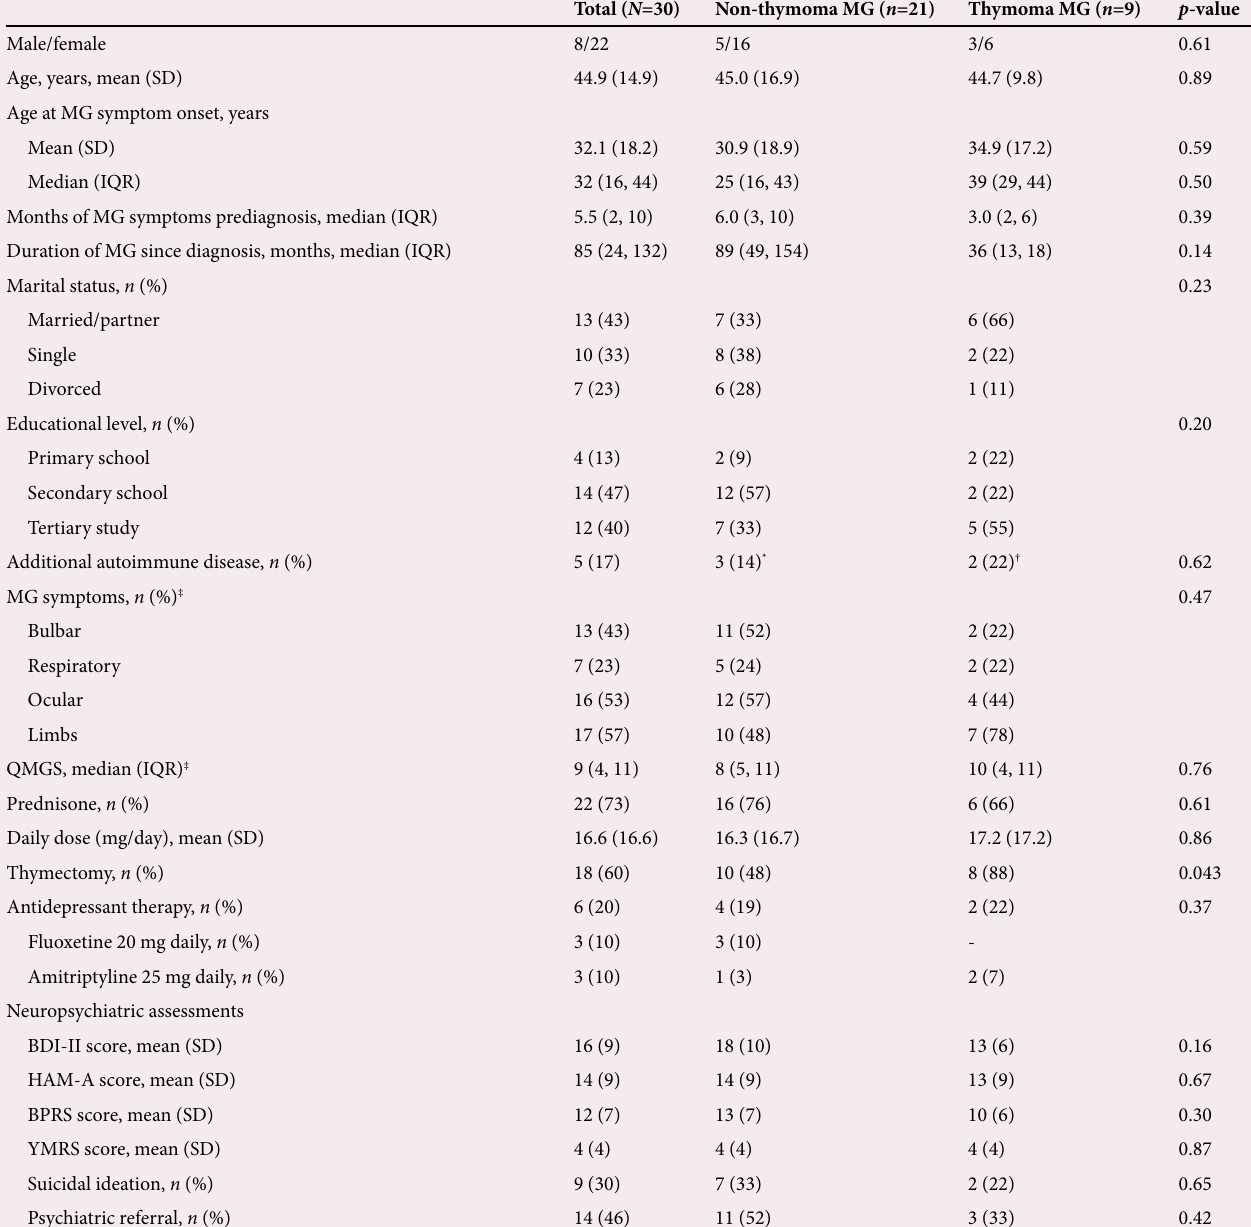
Table 1. Clinical and demographic characteristics of MG patients with or without thymoma, on the day of psychiatric